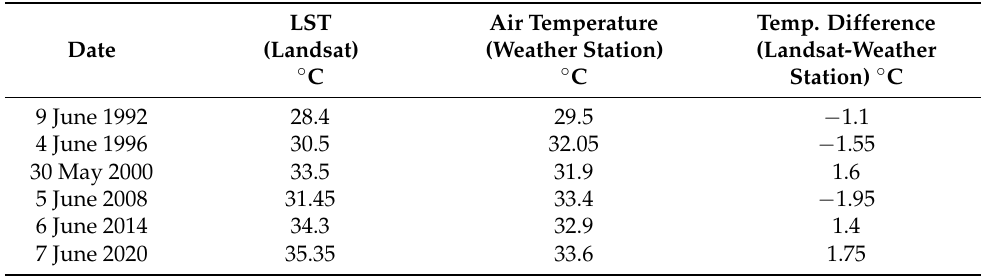
Table 4. Comparison of air temperature recorded at the weather station and the surface temperature derived from the image at the same location (data collected from Lahore Pilot Balloon